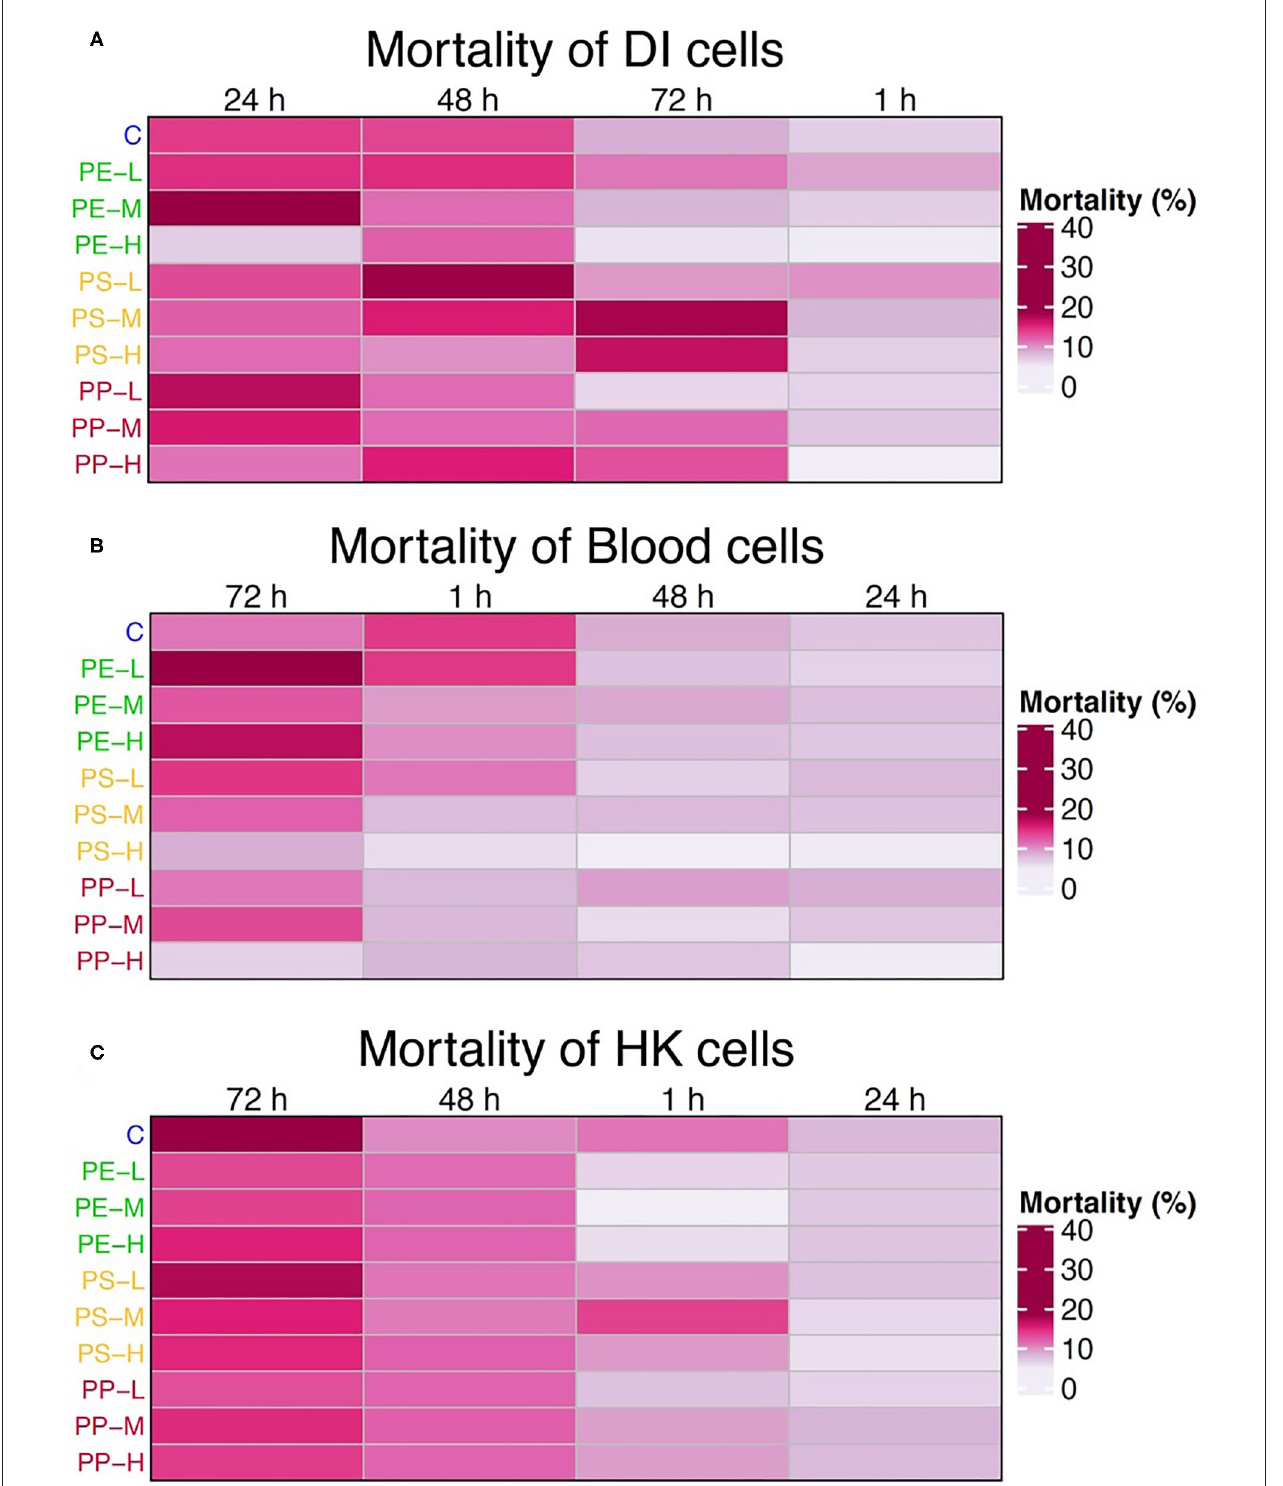
FIGURE 1 | Heatmaps showing the average mortality of (A) intestinal, (B) blood, and (C) HK cells at 1, 24, 48, and 72h for each treatment group. Time is arranged based on the decreasing level of mortality, from left to right. Cell treatments on the left of the map are color coded based on the polymer types: blue = control, green = PE, yellow = PS, and red (PP) = PE + PS; and ordered by concentration (L = 0.05 mg/L, M = 5 mg/L, and H = 50 mg/L). The mortality is expressed as the percentage of dead cells (cells with red fluorescence) from the total number of cells.